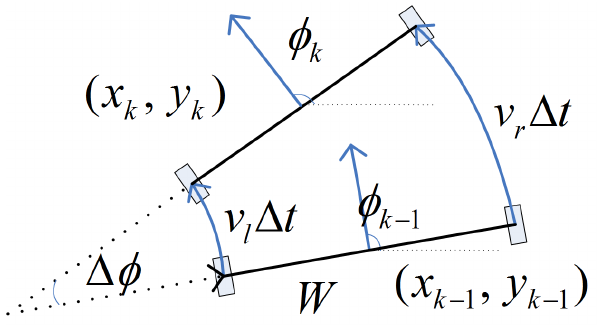
Figure 8. The pose when the robot